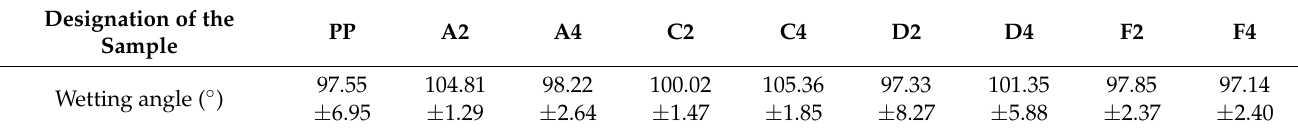
Table 6. Results of the wetting